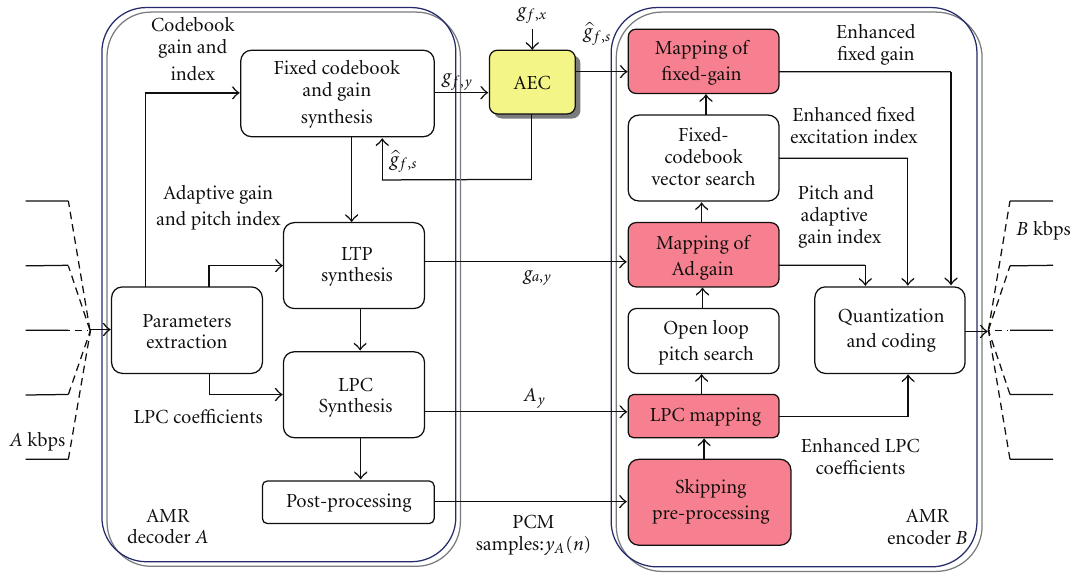
Figure 2: The proposed architecture.